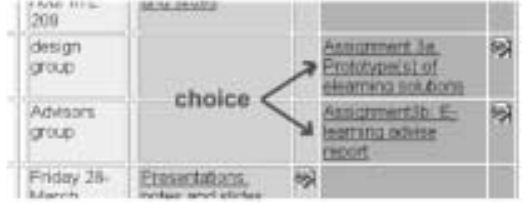
Figure 3. Options in orientation through